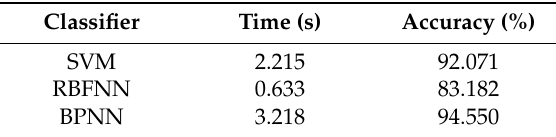
Table 1. Load classification effects in three